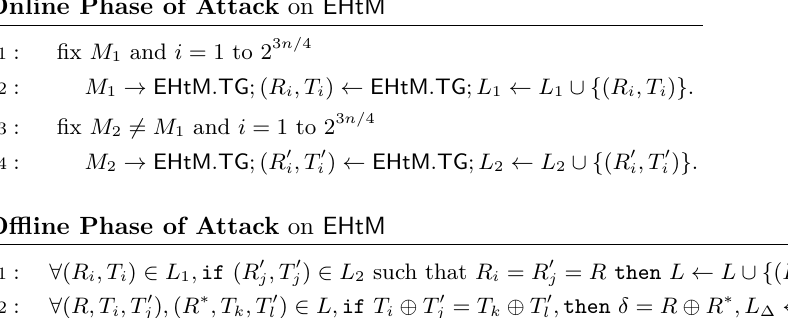
= R 0 , R k = R 0 i j l